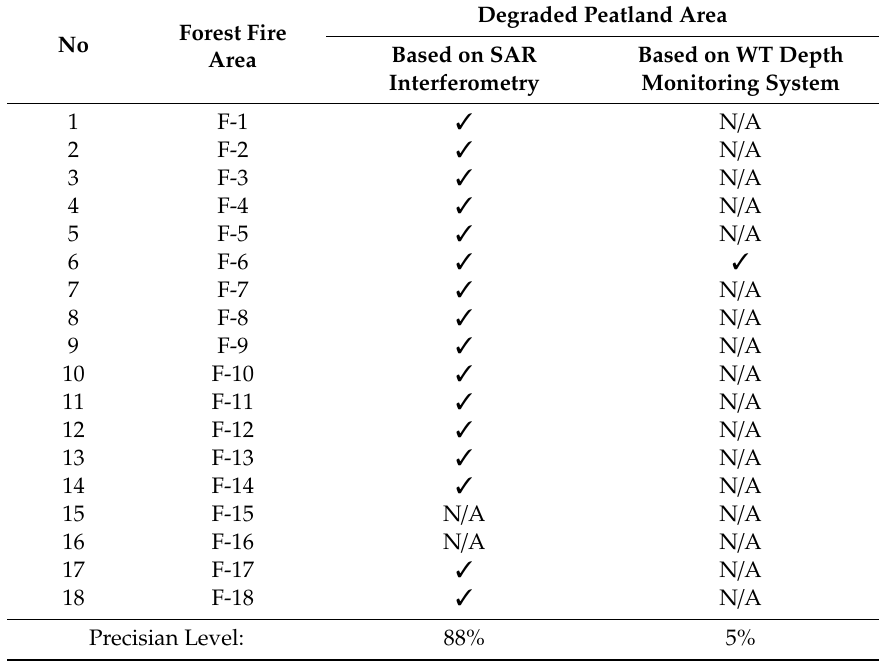
Table 3. Precisian level of degraded peatland identification based on SAR interferometry and water table depth monitoring